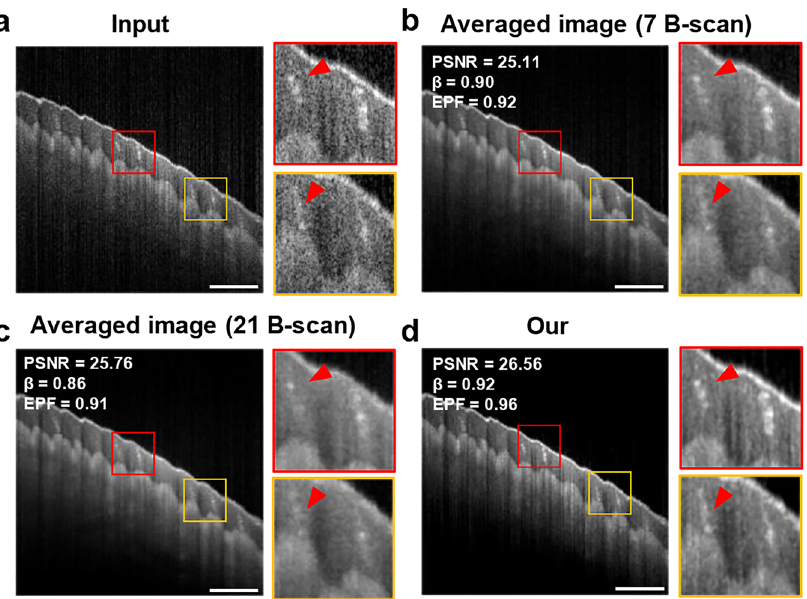
Fig. 4 Comparison with multi-B-scan average method. a A single B-scan of the fi nger tip used as input to the deep learning framework. b , c Results of speckle reduction via multi-B-scan averaging of 7 and 21 B-scans, respectively. The multi-B-scans were acquired with a frame interval of 2 μ m. d Output processed by the proposed deep learning-based framework. The ROIs (red and yellow boxes) on the right side of the image show magni fi ed views (3X). Scale bars, 1